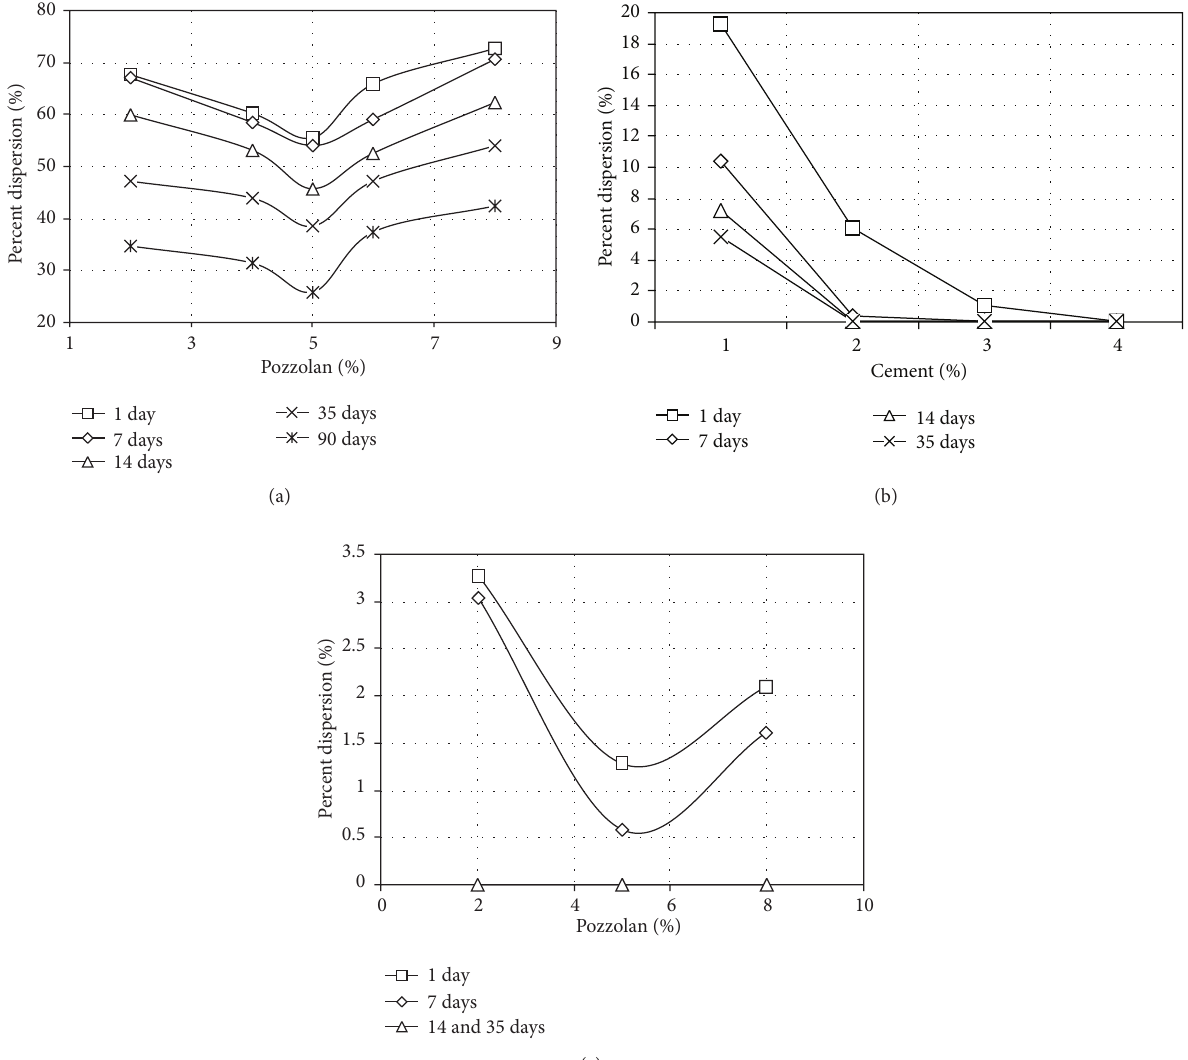
dispersion potential of samples down to zero percent.